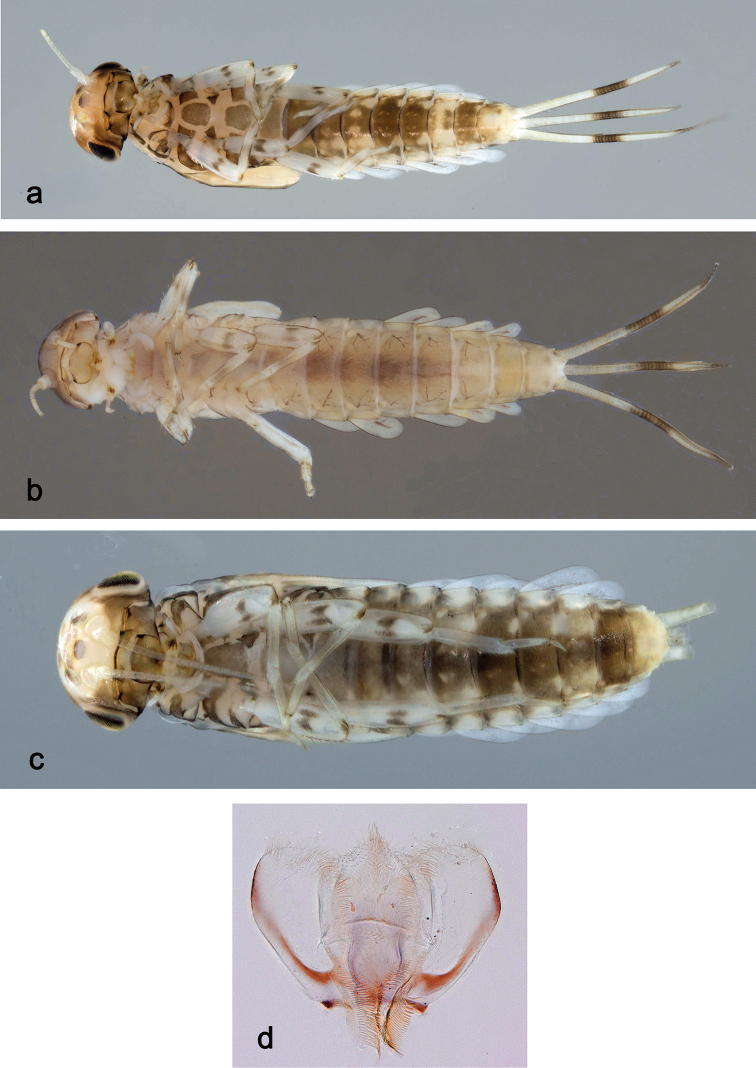
Habitus, larvae, ventral view aLabiobaetis
lachicae sp. nov. bLabiobaetis
palawano sp. nov. cLabiobaetis
sabordoi sp. nov. d Hypopharynx and superlinguae of Labiobaetis
camiguinensis sp. nov.